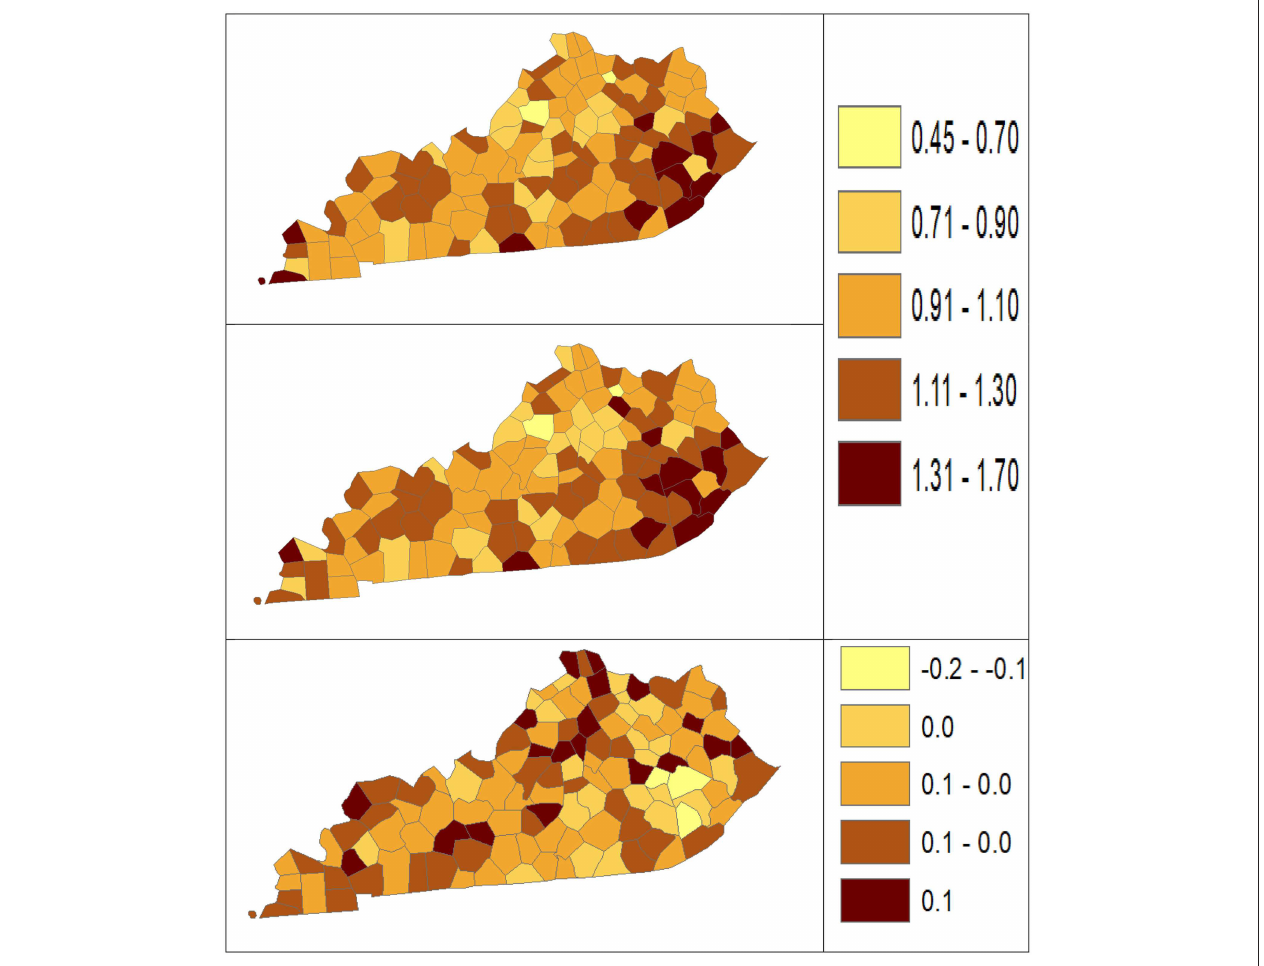
FIGURE 2 | Rate ratio estimated from statistical methods (Direct top vs. BCM middle) and their difference (bottom) using 2006–2010 lung cancer incidence dataset.